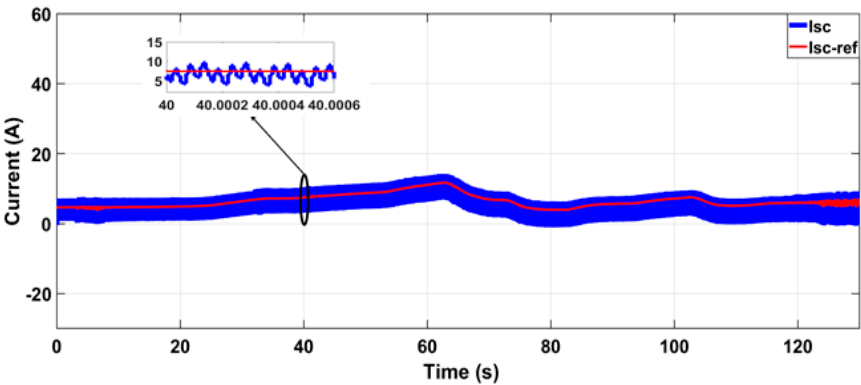
Figure 11. Battery current and reference.